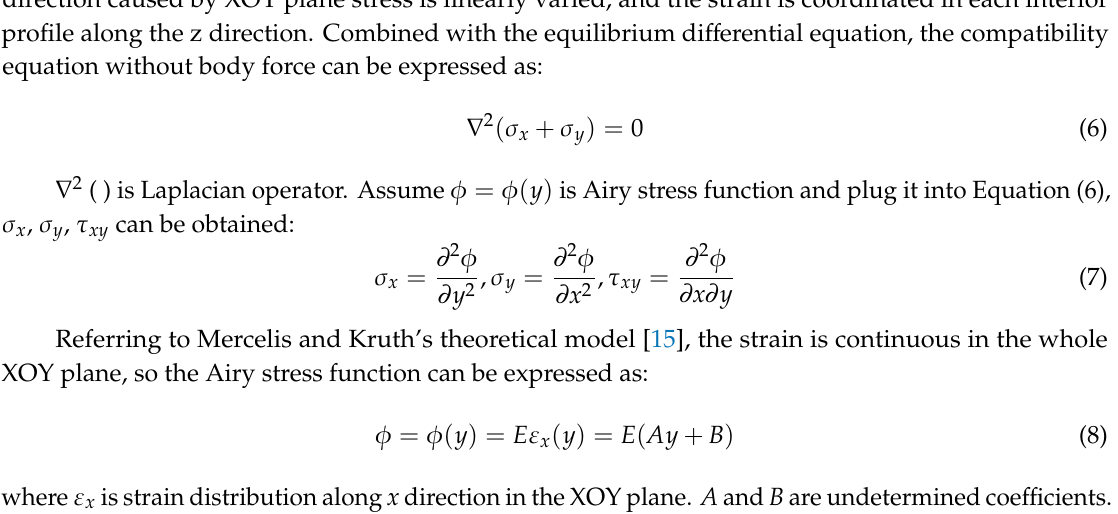
Figure 2. Schematic illustration of the bending moment caused by in-plane residual stress.